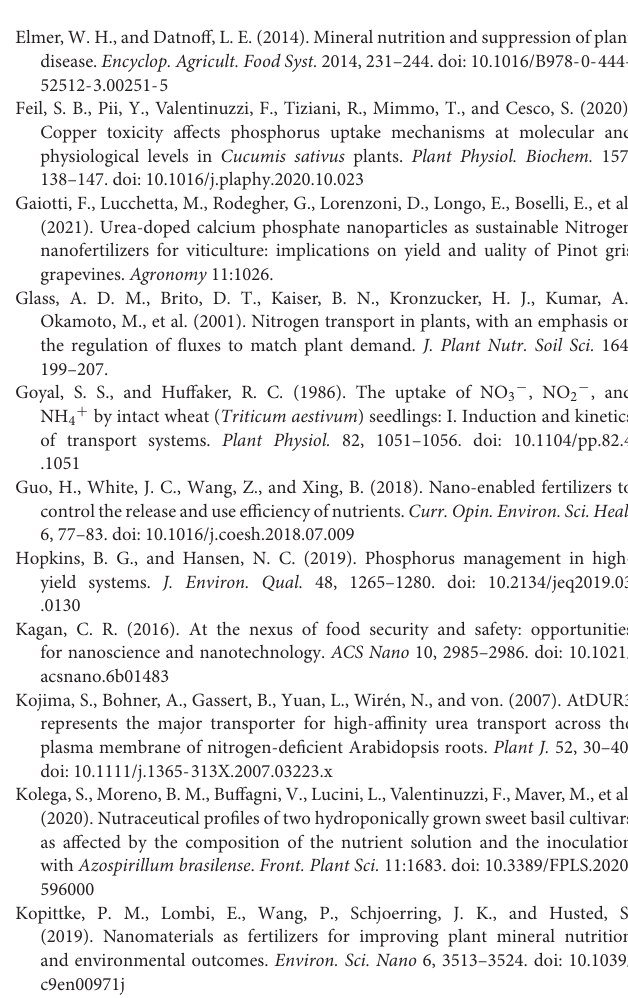
Supplementary Figure 1 | Spectroscopic and diffractometric analyses of U-ACP. Left: FTIR spectra of pure urea (in red), pure ACP (gray), and the U-ACP nanocomposite (black). In the latter spectrum, the starred peaks are assigned to vibrational modes of urea molecules. Right: XRPD spectra collected on of pure urea (in red), pure ACP (gray) and the U-ACP nanocomposite (black). The latter spectrum clearly shows that urea is absorbed by/occluded in ACP and does not appear as a crystalline material.